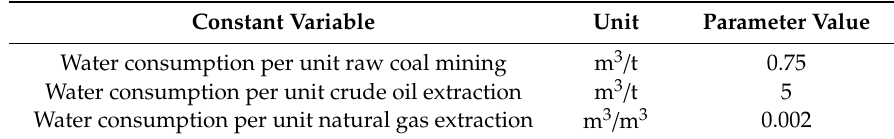
Table 1. Main parameter values of the energy